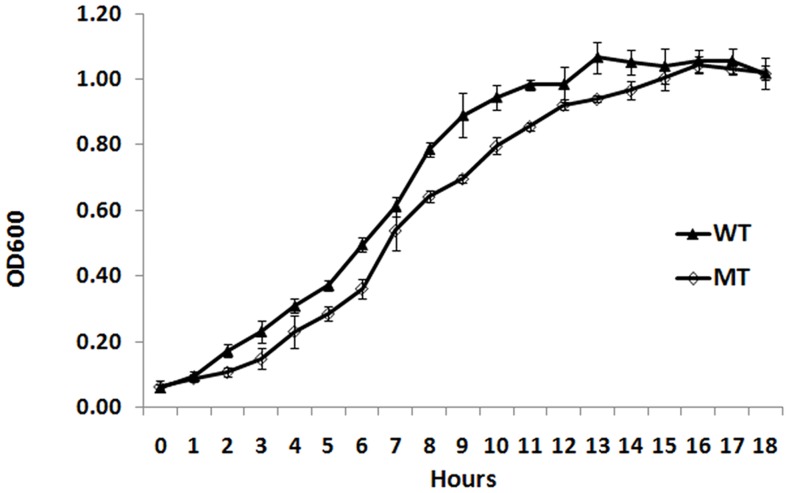
Growth curve of N. gonorrhoeae Rmp deletion mutant and wild-type strains.Same amounts of Rmp deletion mutant and wild-type strains were inoculated to FB liquid culture medium, from which 10 µl was sampled to measure the OD600 value every one hour.